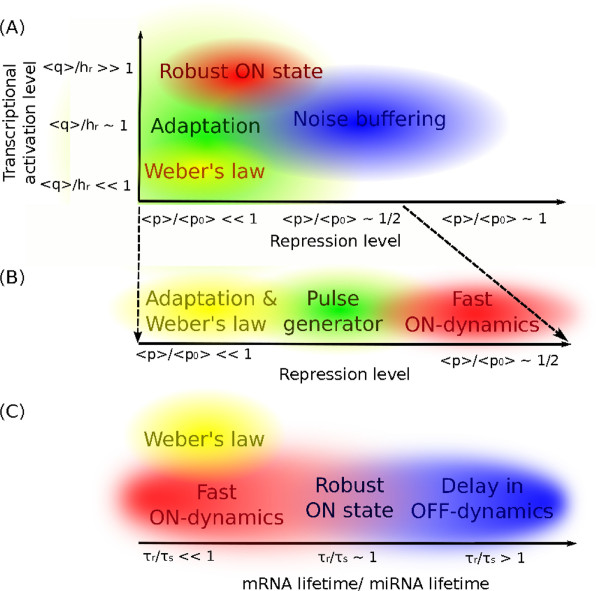
Map of functions for an intronic miRNA-mediated self-loop.(A) An ON-state of host gene expression is defined by full promoter induction (〈q〉/hr ≫ 1), and a sufficiently strong miRNA repression (〈p〉/〈p0〉 < 0.5) can keep it robust in presence of temporary drops in the activator concentration. In the strong repression regime (〈p〉/〈p0〉 ≪ 1) adaptation can be observed, and for almost linear transcriptional activation (〈q〉/hr ≪ 1) the host gene response can show an adaptive dynamics following Weber’s law. Fluctuations can propagate from the upstream TF more efficiently if the target promoter is highly sensitive to changes in TF level (〈q〉/hr ≈ 1), thus in this parameter region noise buffering is more relevant, with a maximum in efficiency for intermediate repression (〈p〉/〈p0〉 ≈ 0.3). (B) A zoom on the strong repression region shows a transition between different dynamics. A step input can induce a fast transition of the host gene expression between two distinct steady states, but increasing further the repression the two steady states become progressively closer, up to their overlap when adaptation and Weber’s law are implemented. (C) The dynamics is strongly influenced by the relative stability of miRNAs and mRNAs. A short mRNA lifetime is a condition for Weber’s law implementation and contributes to the fast switch-on of the host gene expression. On the other hand, the delay in the switch-off dynamics is larger for short-living miRNAs. In the intermediate region, where the two half-lives are comparable, the trade-off between the two dynamical properties makes the highly-expressed state of the host gene robust with respect to fluctuations in the activator.